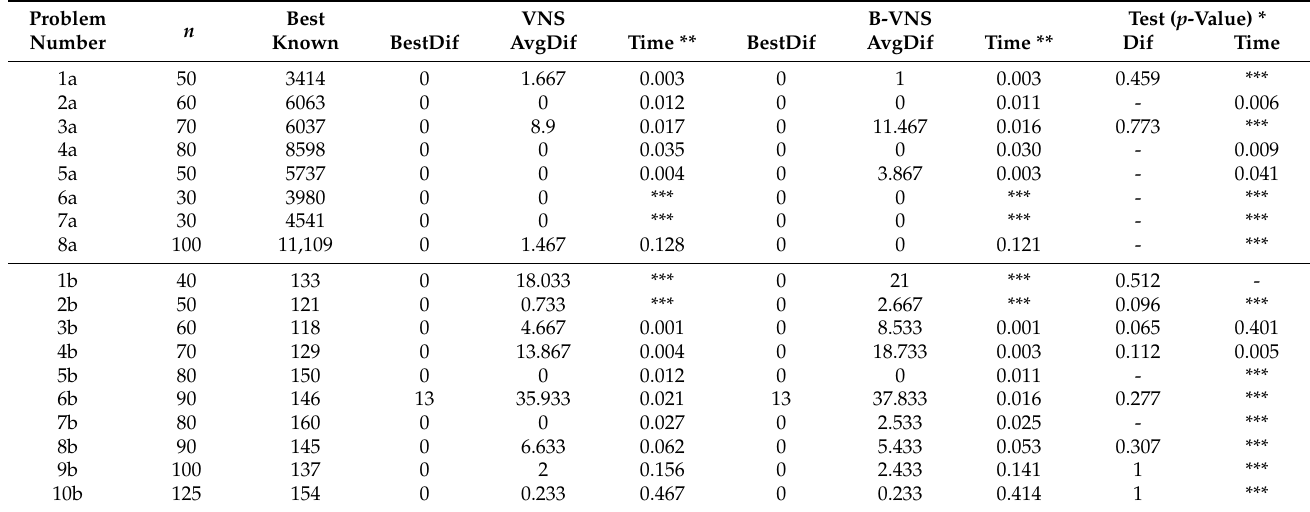
Table 1. Results for Glover [11]